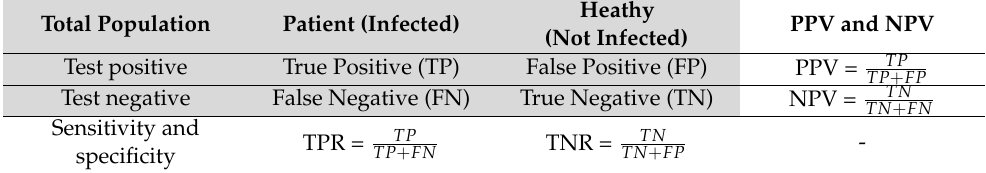
Table 1. Clinical characteristics of a biosensor.